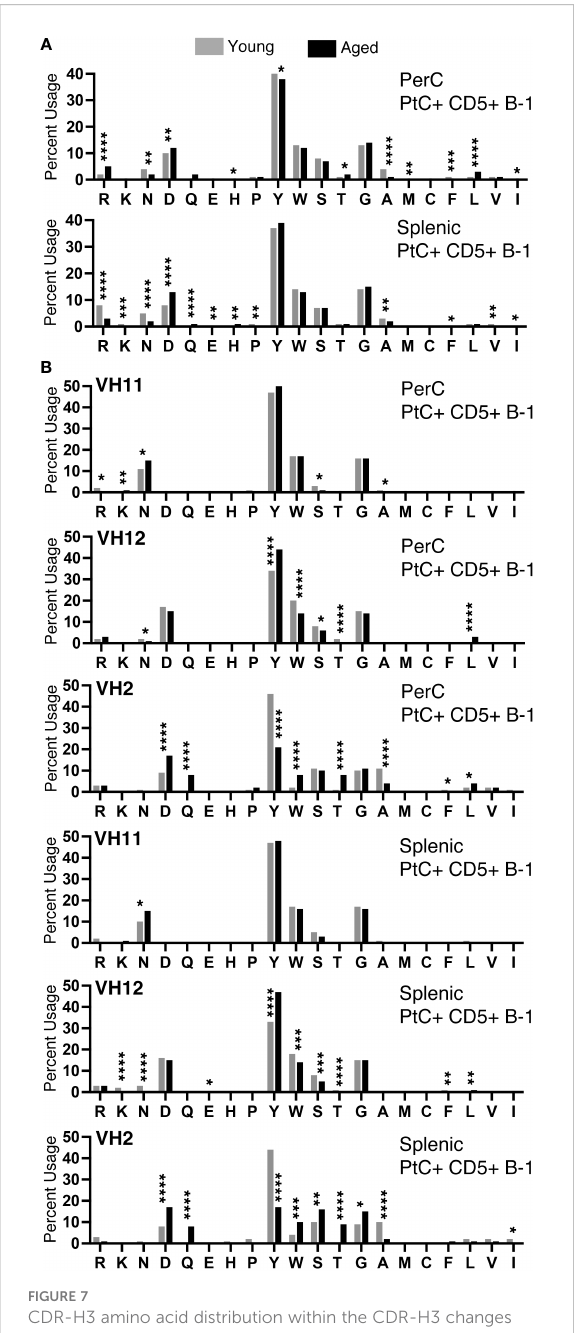
FIGURE 7 CDR-H3 amino acid distribution within the CDR-H3 changes with age. The percent of each amino acid used within the CDR- H3 was determined for each PtC+CD5+ B-1 cell subset as indicated. (A) Peritoneal and splenic PtC+CD5+ B-1 cells. (B) Peritoneal and splenic PtC+CD5+ B-1 cells utilizing VH11, VH12, or VH2. These results are based on sequences obtained from experiments performed in Figure 2. Results are based on 4 independent experiments with sequences combined from each independent experiment (n=11 for 3-month-old mice, n=15 for 23-26-month-old female mice). Statistics used: Chi-square test. Asterisks for p values: *p<0.05, **p<0.01, ***p<0.001,